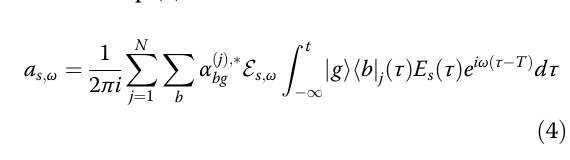
¼ 35 fs for broadband 0